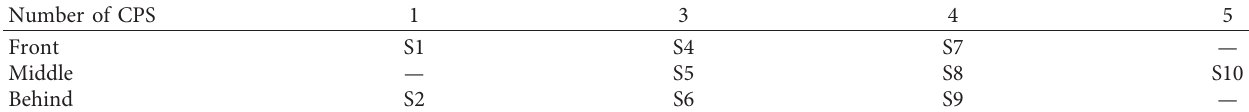
Table 7: Classification of CPS number and